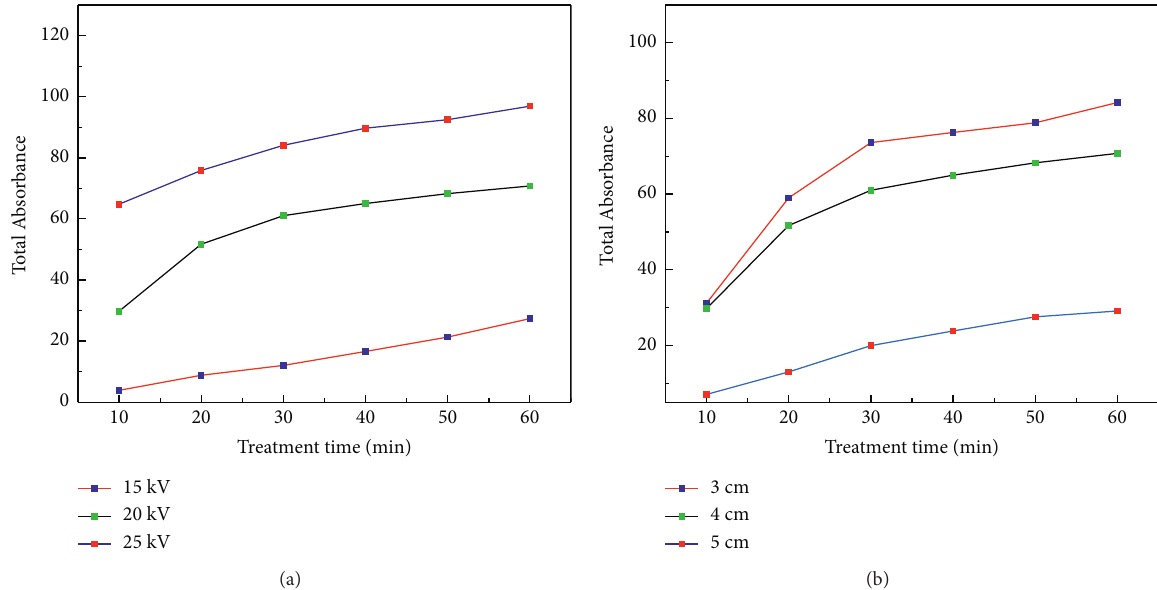
Figure 11: Total absorbance values at (a) voltages of 15, 20, and 25kV and the needle-dielectric plate distance of 4cm and (b) voltage of 20kV and the needle-dielectric plate distance of 3, 4, and